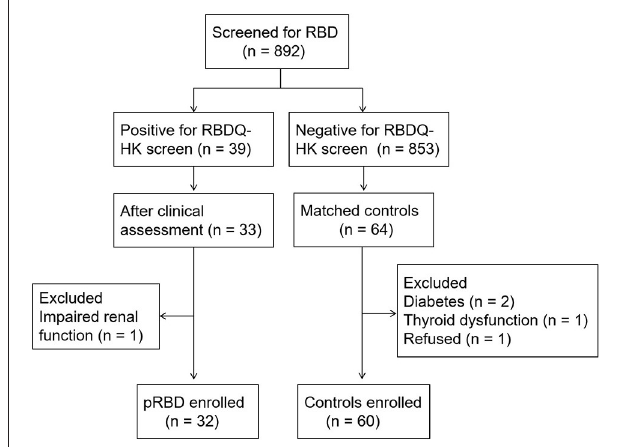
FIGURE 1 | The flowchart of participant